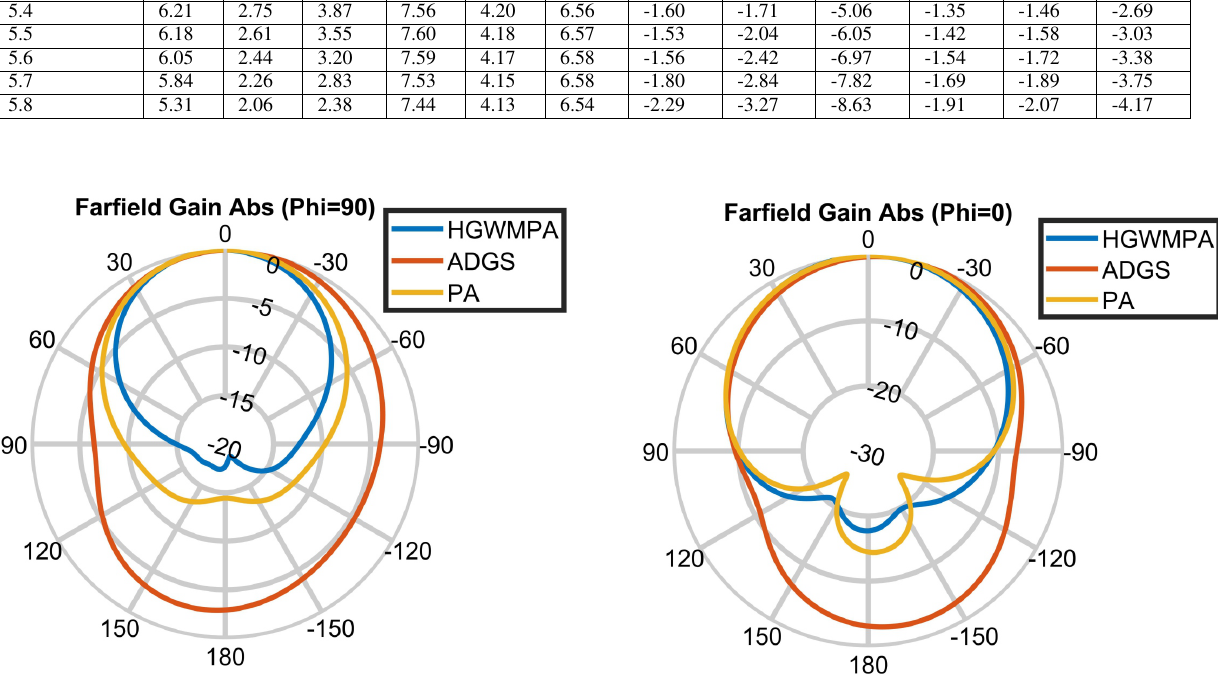
FIGURE 10. Normalized radiation patterns of the PA, ADGS and HGWMPA at 5.8 GHz (Phi=90 deg. plane).